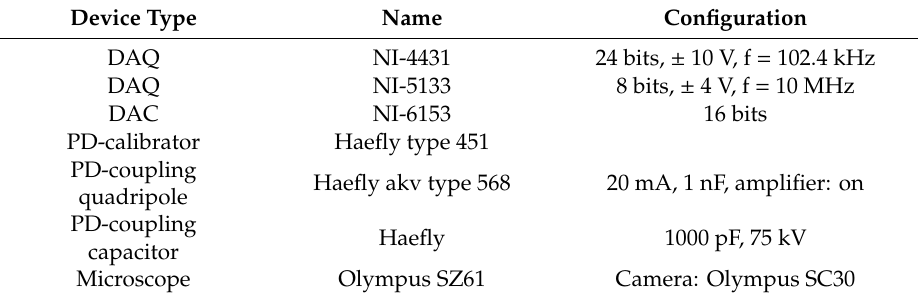
Table 1. A summary of the devices in use.